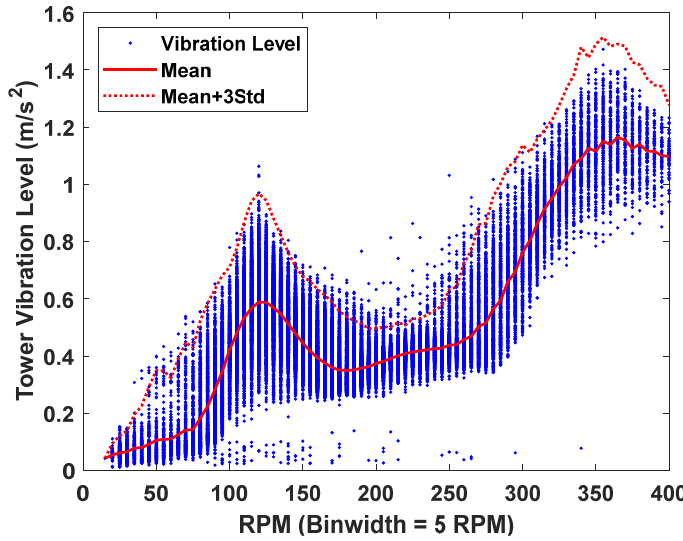
Figure 11. Maximum vibration level of the tower for each 1-minute data set.